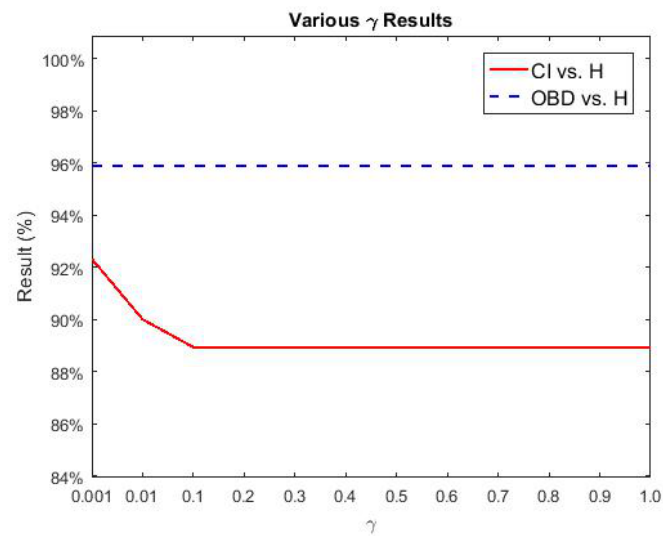
Figure 16. Various γ results of BD sub-classes vs. H.